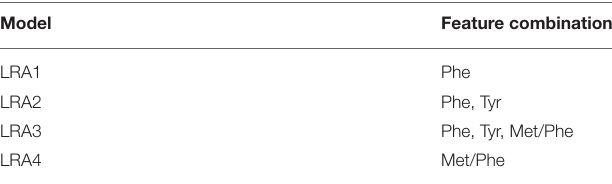
TABLE 4 | Model developed utilizing features from previous work (LRA5) and our optimal model (LRA3).